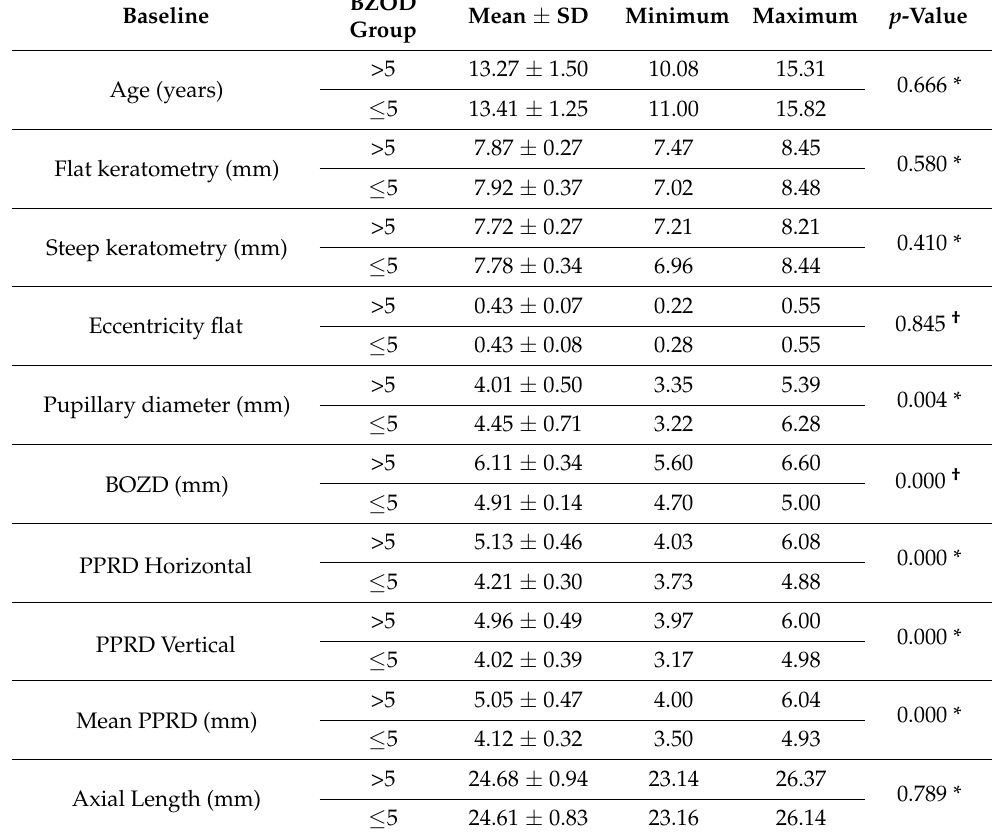
BOZD: back optical zone diameter; PPRD: plus power ring diameter; SD: standard deviation. * independent t -test; † Mann-Whitney